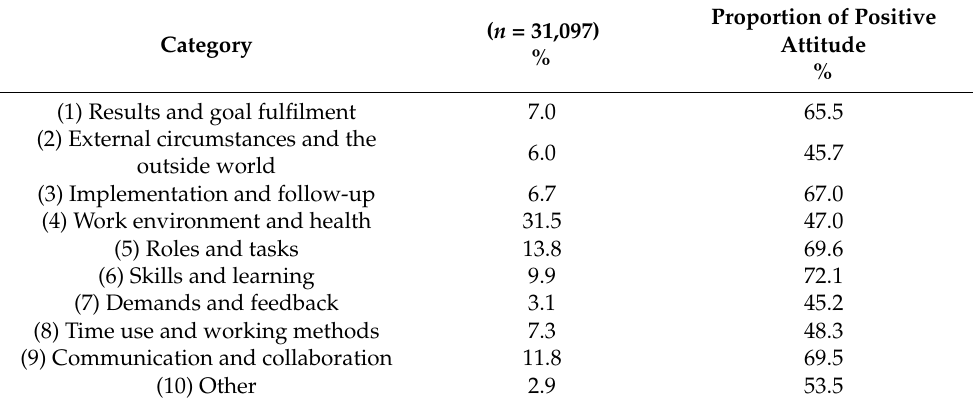
Table 5. Respondents’ categorization of free-text